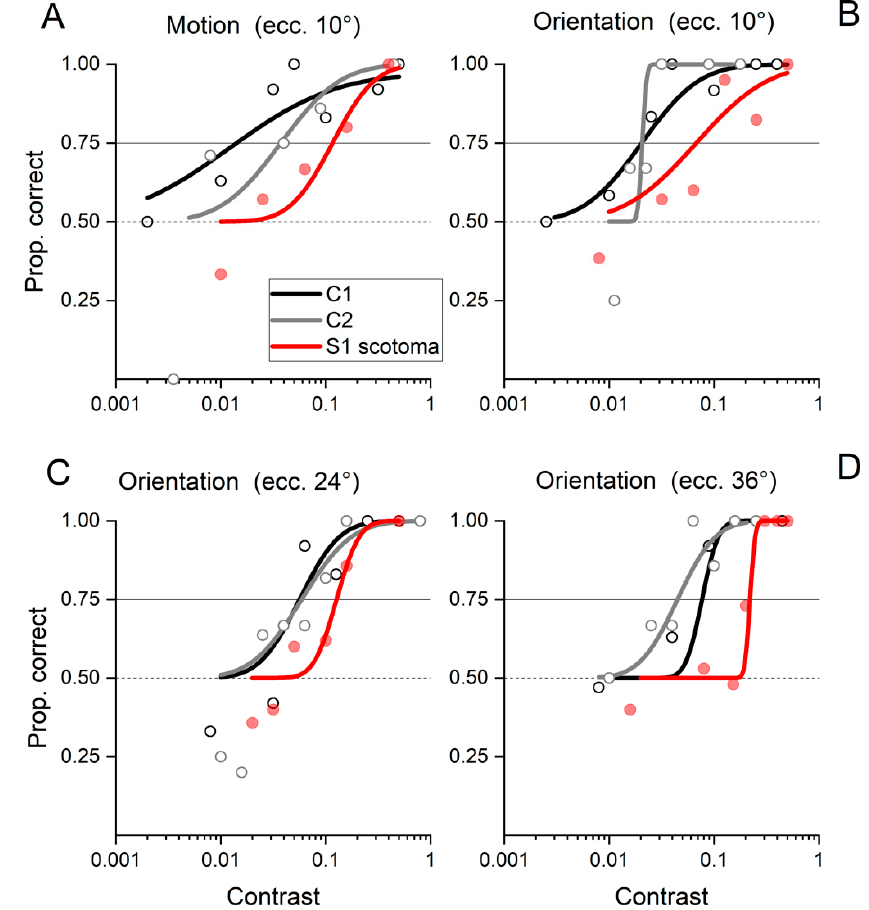
Figure 1. Psychophysical assessment of contrast sensitivity in Patient IB and two age-matched controls . ( A ) Contrast sensitivity for motion discrimination at 10° of horizontal eccentricity. ( B – D ) controls. ( A ) Contrast sensitivity for motion discrimination at 10 ◦ of horizontal eccentricity. Contrast sensitivity for orientation discrimination at 10°, 24°, and 36° of horizontal eccentricity, ( B – D ) Contrast sensitivity for orientation discrimination at 10 ◦ , 24 ◦ , and 36 ◦ of horizontal respectively. eccentricity,